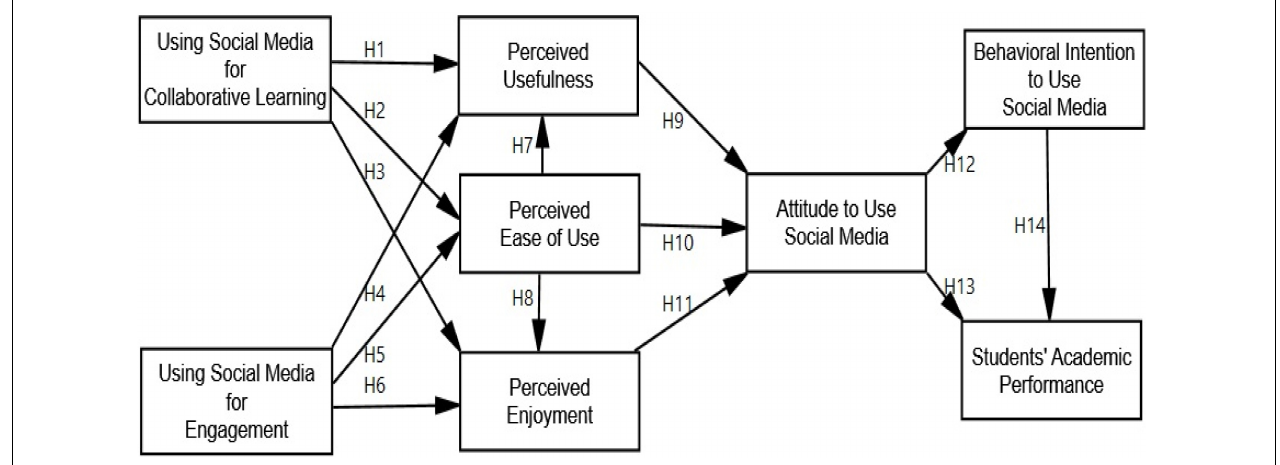
FIGURE 1 | Research